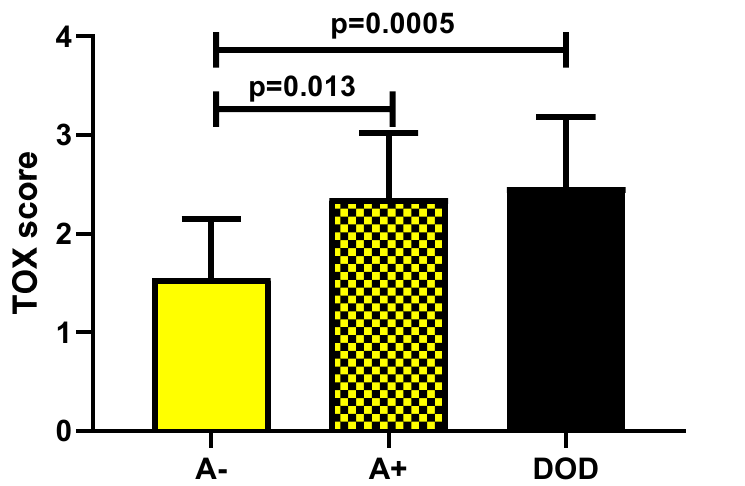
Figure 5. TOX expression in A − (alive without disease) versus A+ (alive with disease) and DOD (dead of disease) patients.